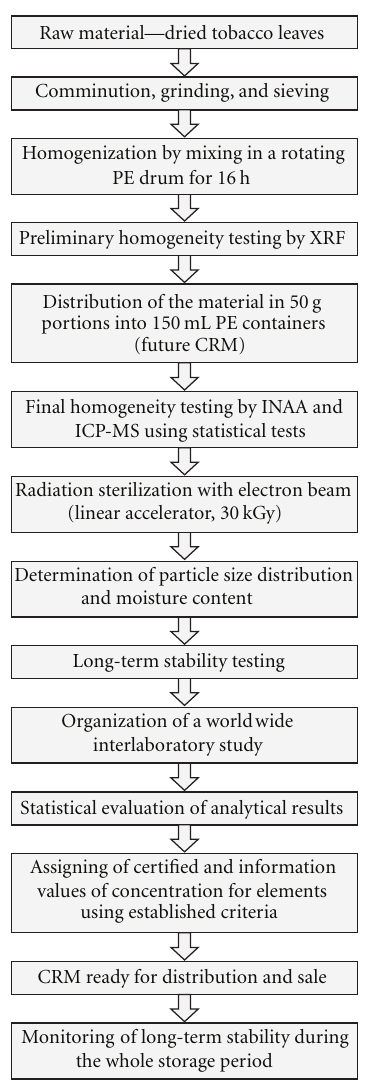
Figure 1: General strategy of production and certification of the new reference